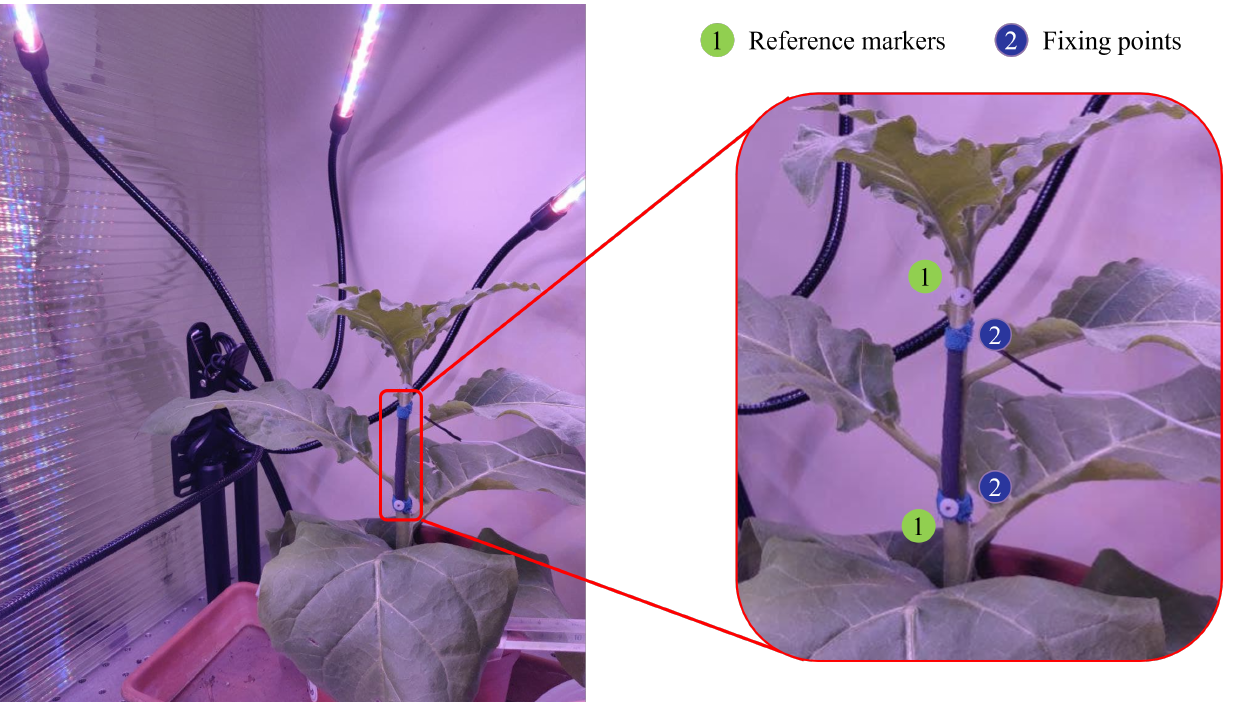
Figure 3. Experimental setup for the stem growth monitoring. The polycarbonate chamber in which the plant and the LED lights were placed is showed on the left. The sensor fixing points and the growth reference markers positioning on the stem are shown on the right.